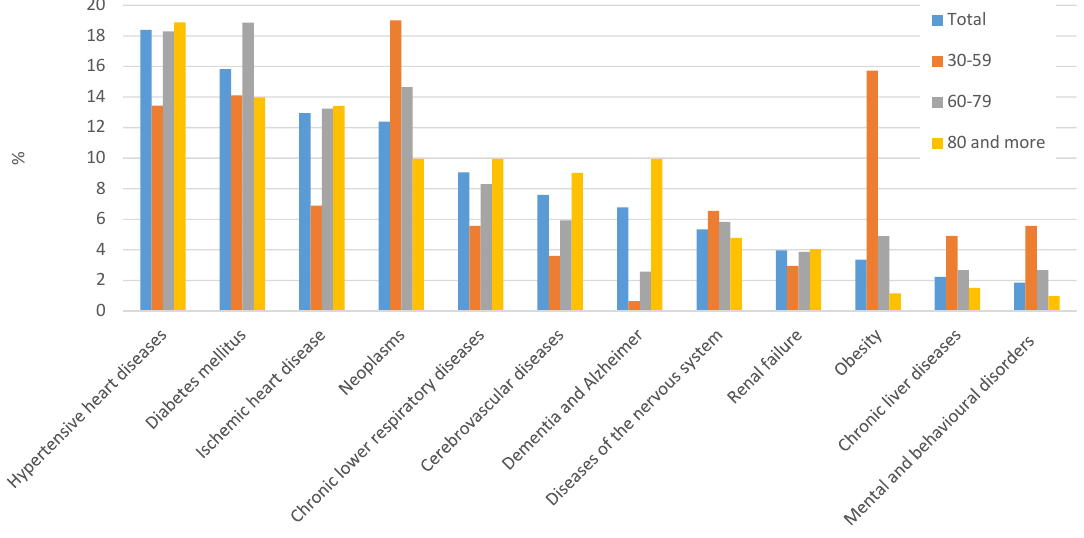
Figure 1. Distribution of the main comorbidities on death certificates, by age group.